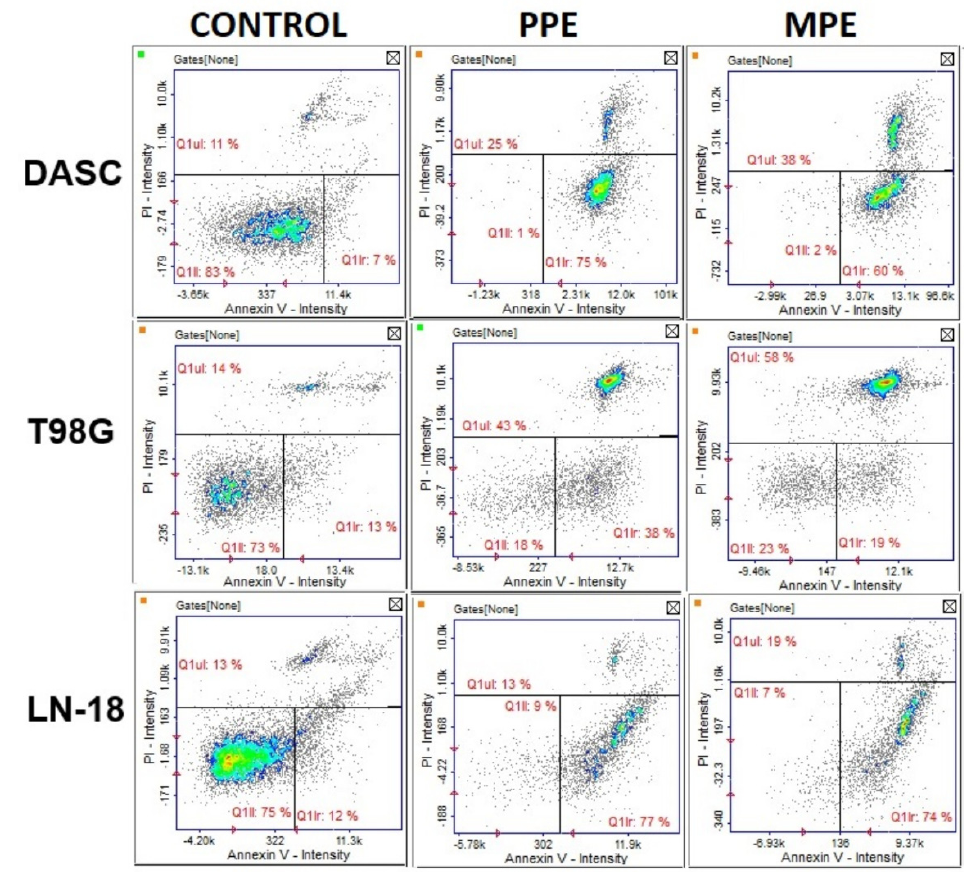
Figure 5. The quantitative assessment of DASC, T98G and LN–18 cells apoptosis induced by PPE and MPE (30 μ g/mL) using Annexin V/PI staining.